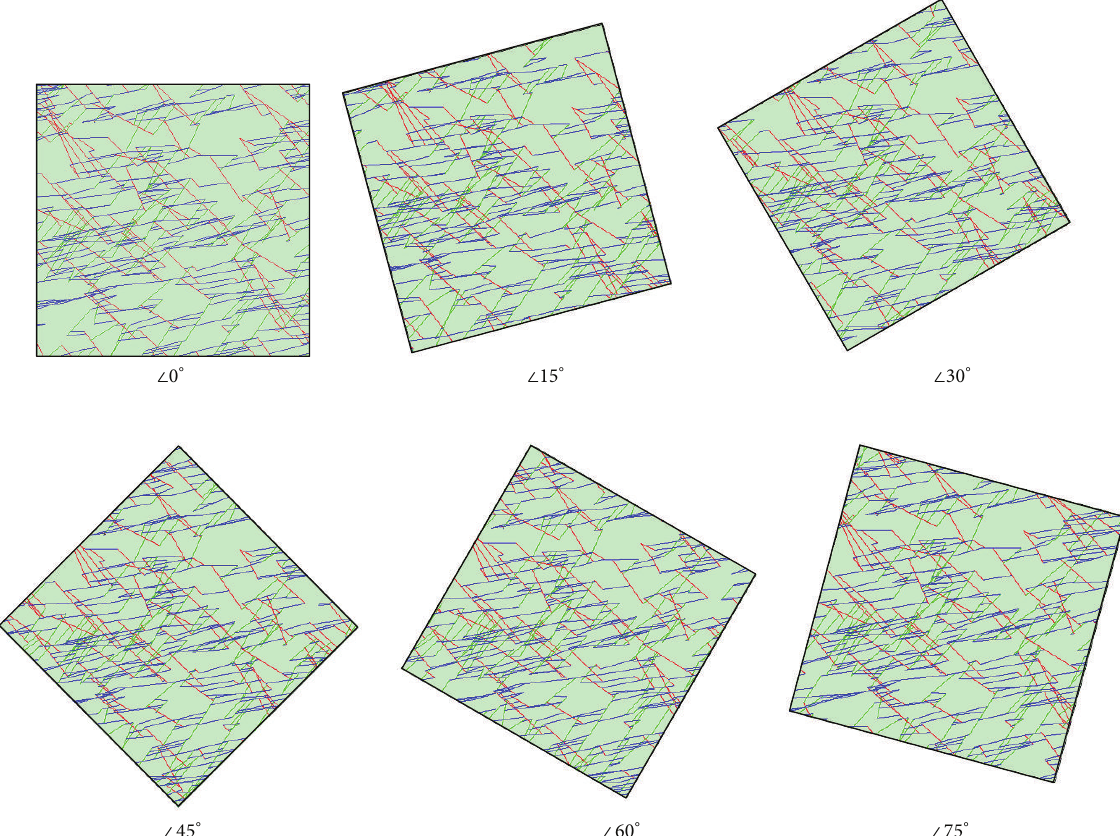
Figure 11: Fracture network in the study area with edge length of 7 m.